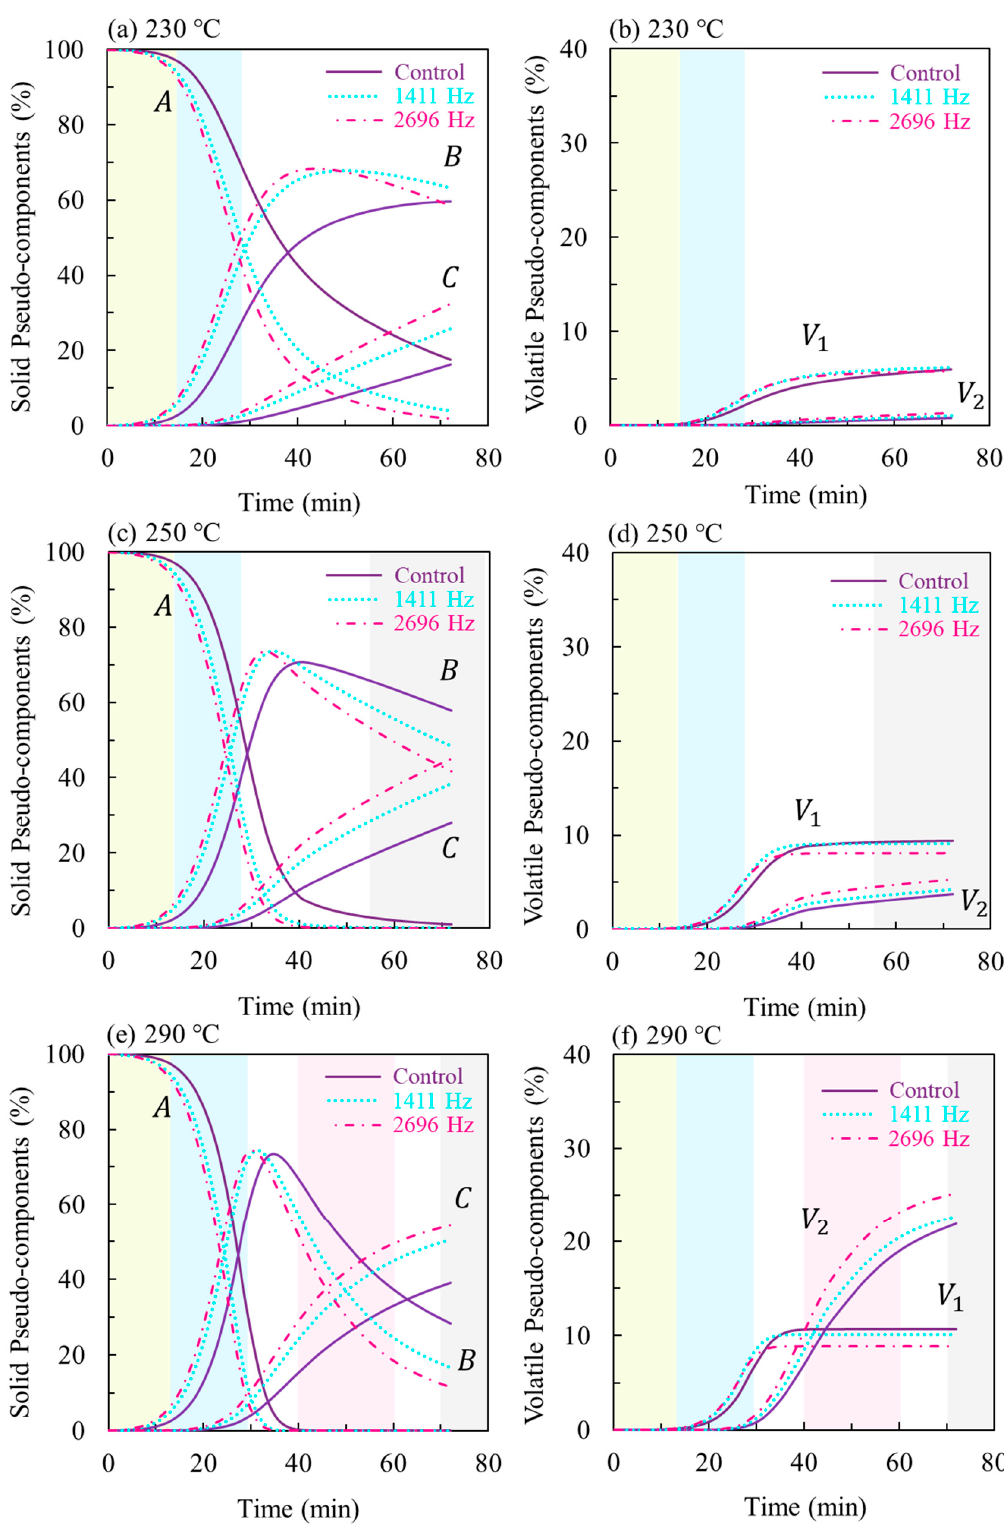
Figure 6. Solid and volatile pseudo-components evolution for control and acoustic 1411 and 2696 Hz treatments under ( a ) 230 ( b ) 250, and ( c ) 290 °C.